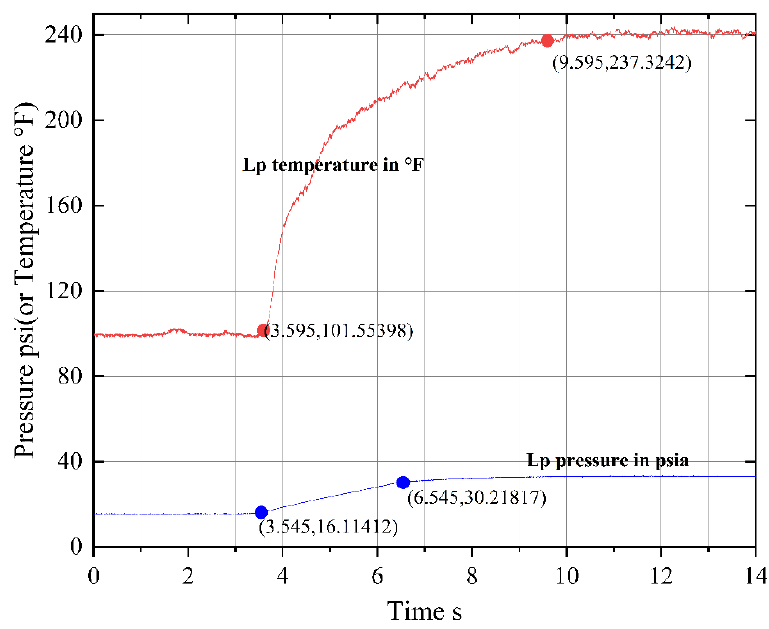
Figure 11. The HP bleed air temperature and pressure rapid rise characteristics of the cooling ‐ pack ‐ age ‐ two on HPR.